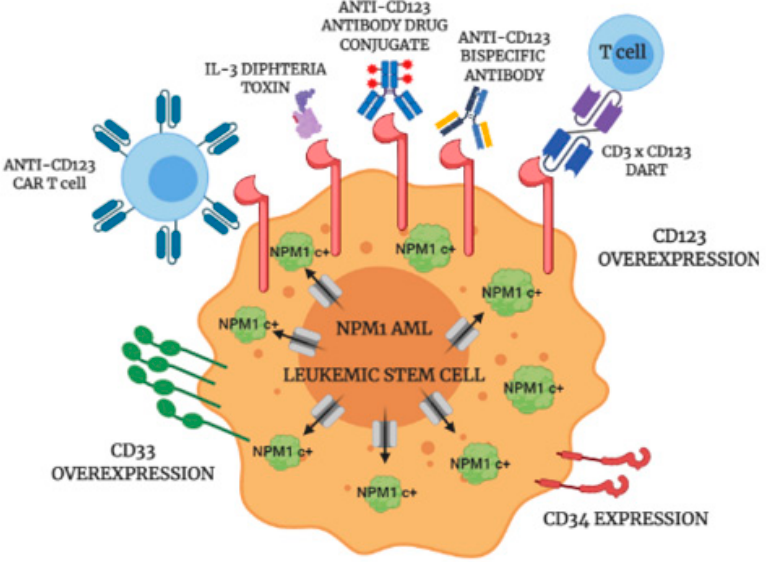
Figure 6. Anti-CD123 targeted therapies. Cartoon depicting the possible approaches to target CD123 on NPM1 mut AML LSCs. NPM1c+, mutant NPM1; DART, dual affinity retargeting. Supplementary Materials: The following are available online at https://www.mdpi.com/2072-6694/13/3/496/s1, Table S1: Karyotyping results of all patients enrolled in the